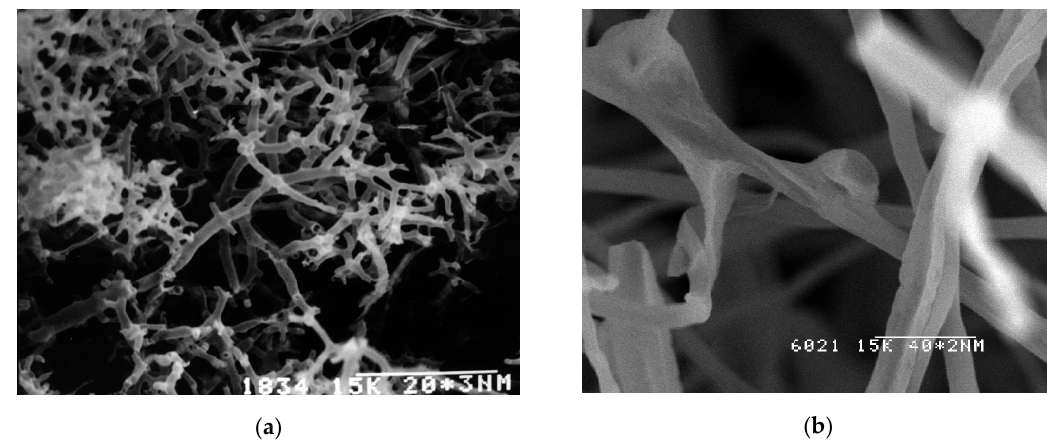
Figure 3. SEM images of G. lucidum mycelium. The coral-shaped mycelium ( a ) and clamp connection ( b